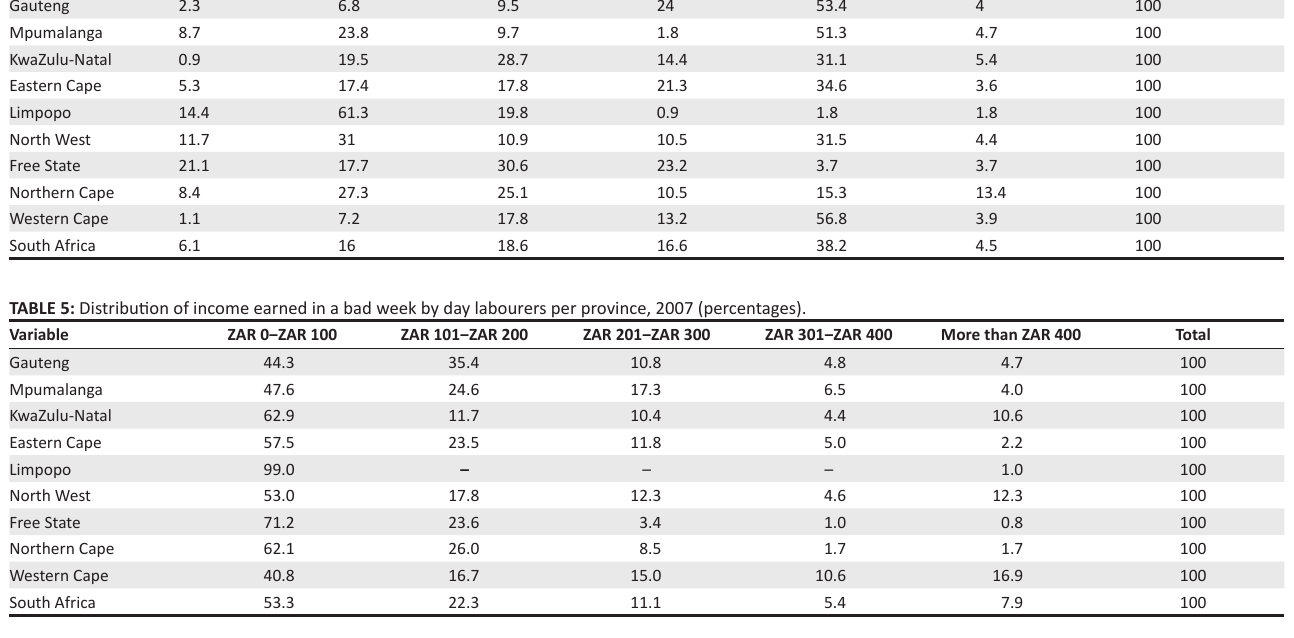
TABLE 4: Distribution of income earned in a good week by day labourers per province, 2007 (percentages).